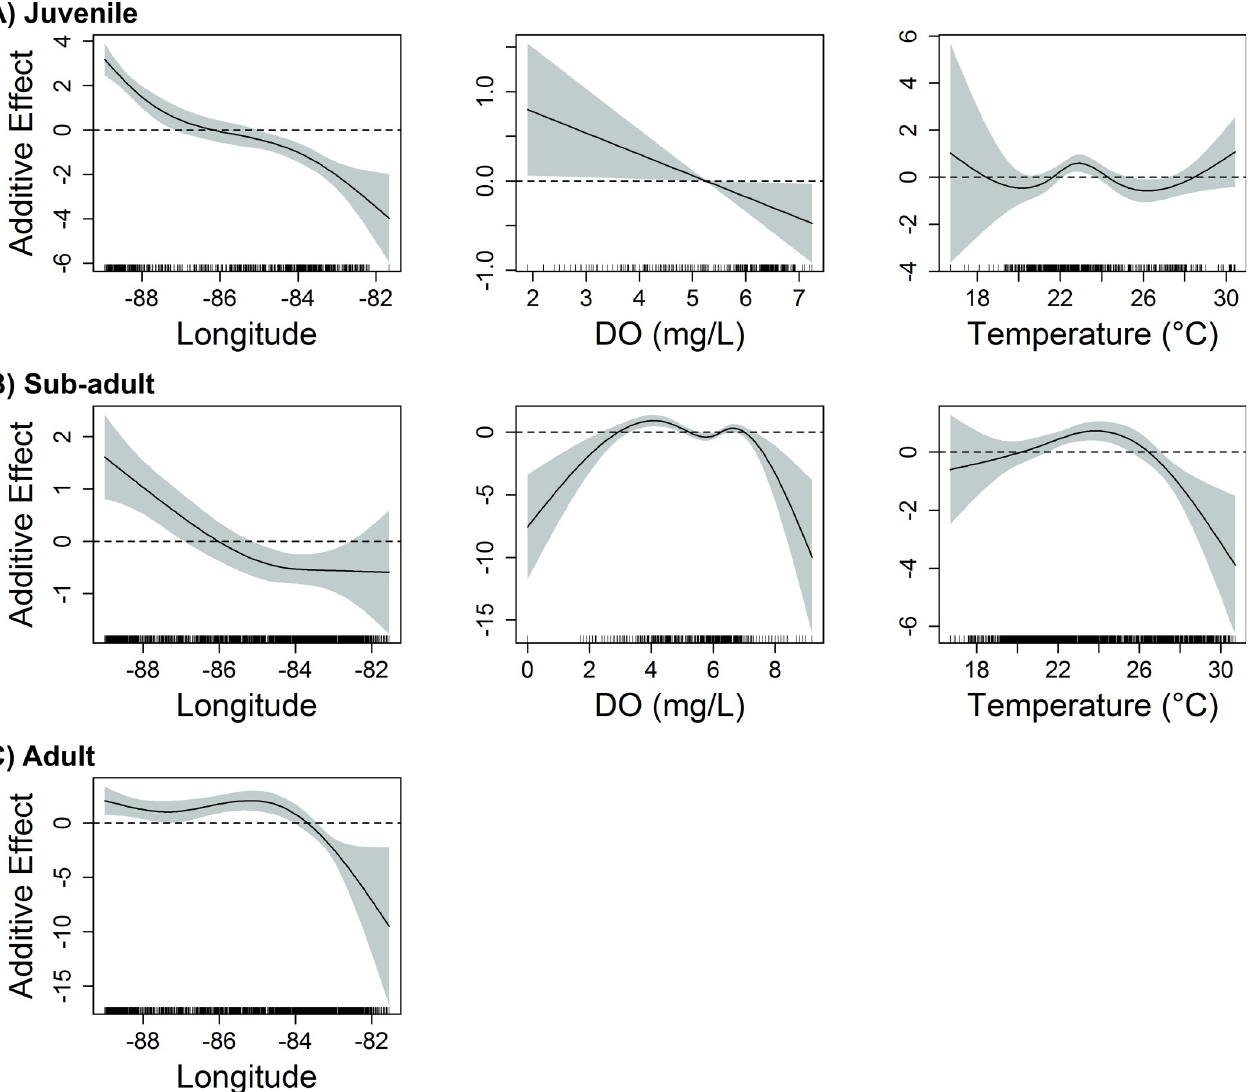
Fig 2. Influence of geographic and physicochemical variables on red snapper abundance in the eastern GoM. Response plots from final generalized additive models show the influence of longitude, bottom dissolved oxygen (DO), and bottom temperature on the abundance of A) juvenile (age-0), B) sub- adult (age-1-2), and C) adult (age-2+) red snapper over unconsolidated bottom in the eastern GoM. Solid lines represent smoothed values, and shaded areas represent 95% confidence intervals. Dashed lines are included at y = 0.